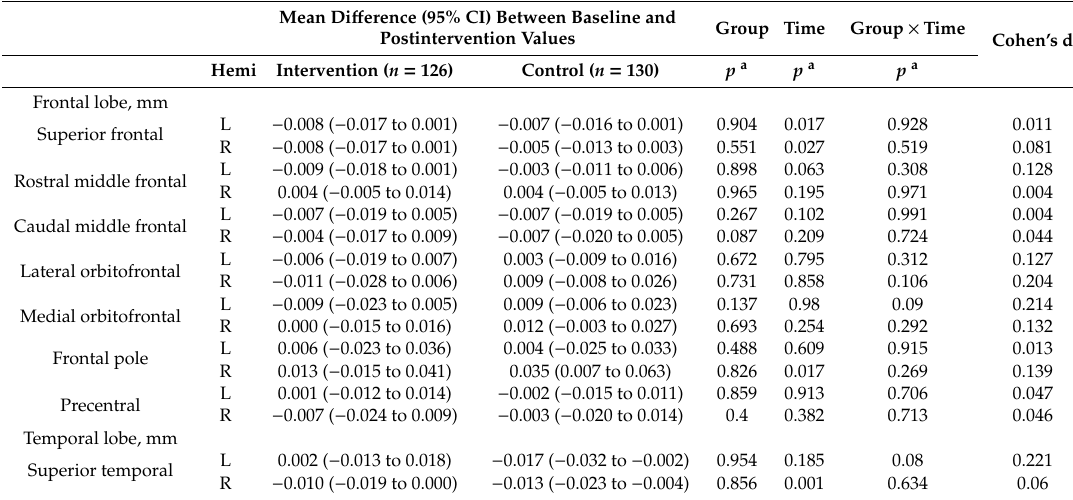
Table 2. Cortical thickness per group and